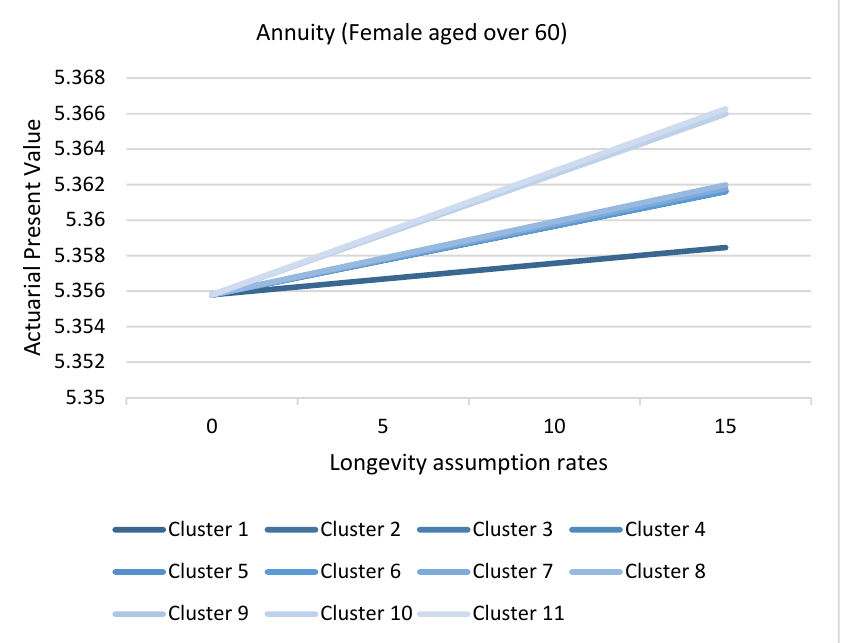
Figure 21. APV for females aged over 60 clusters against longevity assumption rates.